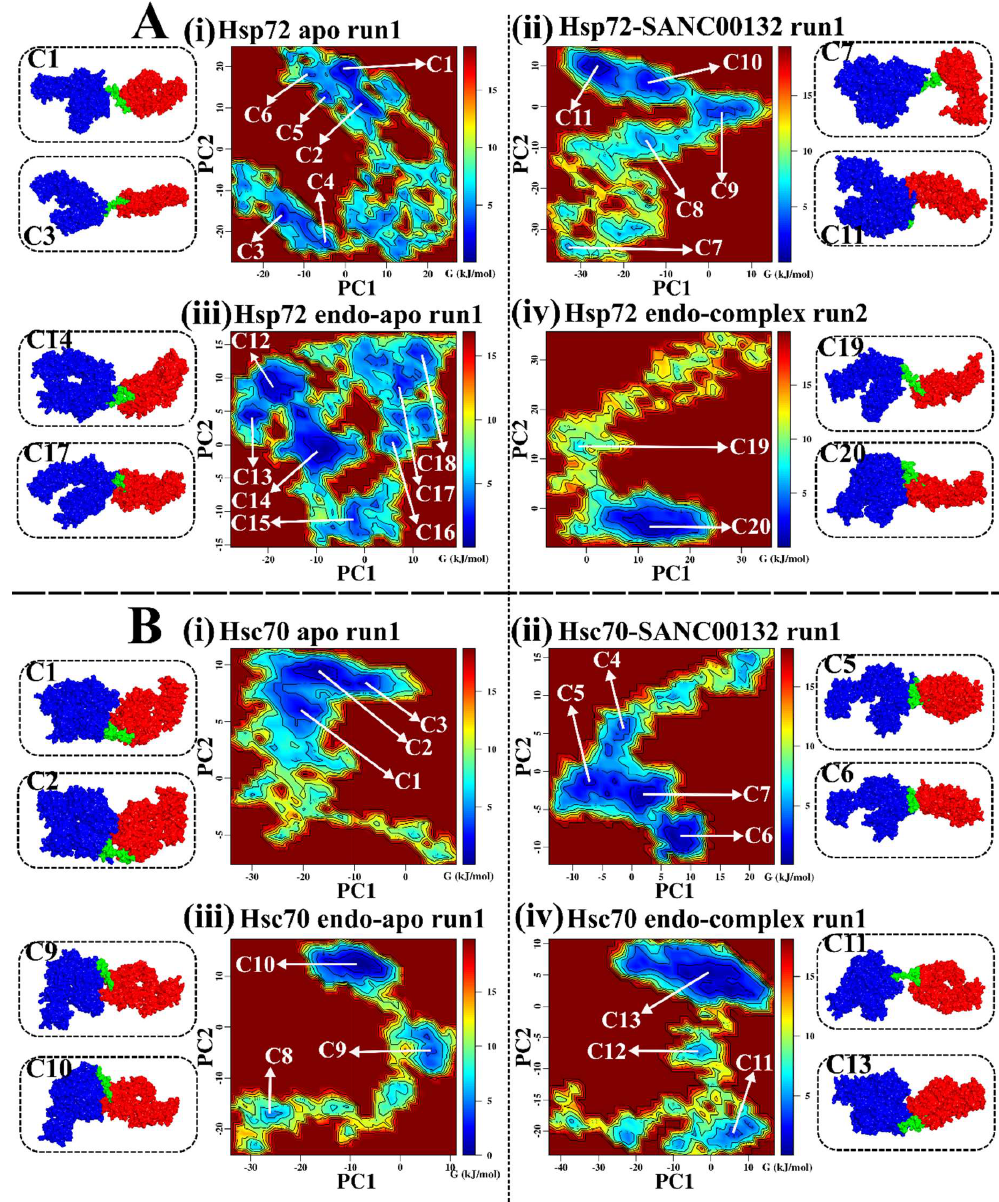
Figure 3. ( A , B ) 2D projections of free energy landscape along the first and second principal components. Comparisons between SANC00132-free and SANC00132-bound systems. Surfaces are coloured based on Gibbs free energy levels from maroon (high energy/maxima) to blue (low energy/minima). Each contour represents an increase of the free energy of 1 kJ·mol -1 . Conformations sampled are labelled from C1–C20 (Hsp72) and C1–C11 (Hsc70), respectively. Snapshots of representative conformations occupying important free energy wells (minima) are shown as surfaces and coloured domain-wise: Blue: NBD, Green: Linker, Red: SBD. A : Hsp72: ( i ) Hsp72 apo Run1, ( ii ) Hsp72-SANC00132 Run1, ( iii ) Hsp72 endo-apo Run1, ( iv ) Hsp72 endo-complex Run2. B : Hsc70: ( i ) Hsc70 apo Run1, ( ii ) Hsc70-SANC00132 Run1, ( iii ) Hsc70 endo-apo Run1, ( iv ) Hsc70 endo-complex Run2. Duplicate trajectory results are shown in the Supplementary Data (Figure S5).